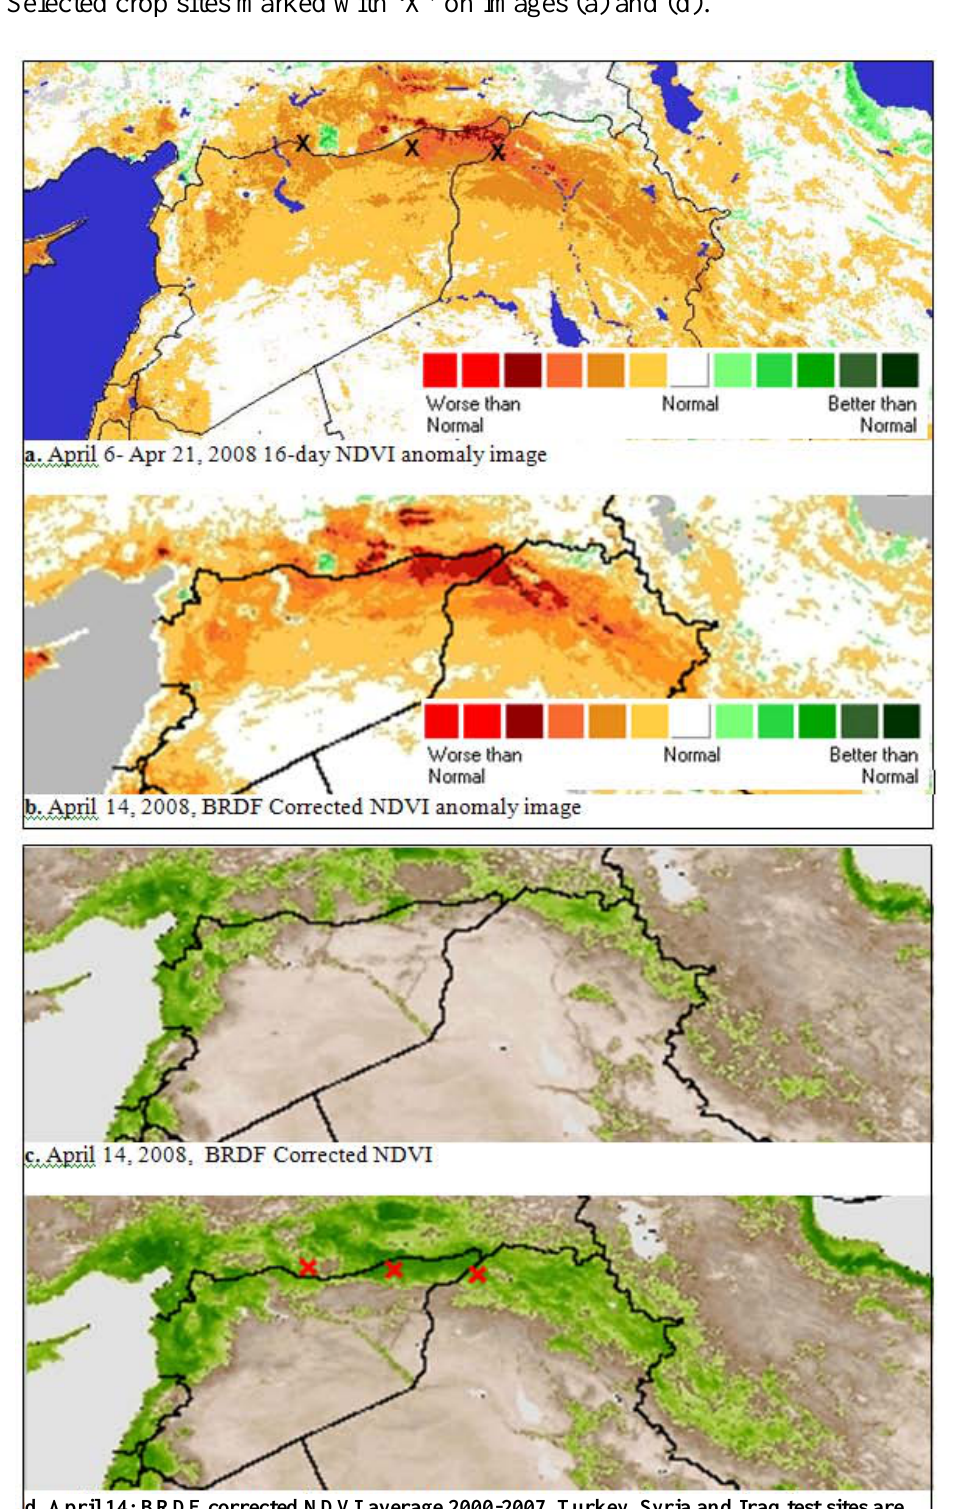
Figure 5. A comparison between the 16-day composite data and the daily, BRDF corrected data for Northern Iraq and Syria. Figure 5a–b show NDVI departure from mean (a) the 16-day MODIS NDVI data (b) from the daily BRDF corrected NDVI data. Areas in brown are indicative of lower than average NDVI values. Figure 5c shows the BRDF-corrected NDVI image from April 14th, 2008, and Figure 5d shows the mean NDVI for April 14, 2008. Selected crop sites marked with ‘X’ on images (a) and